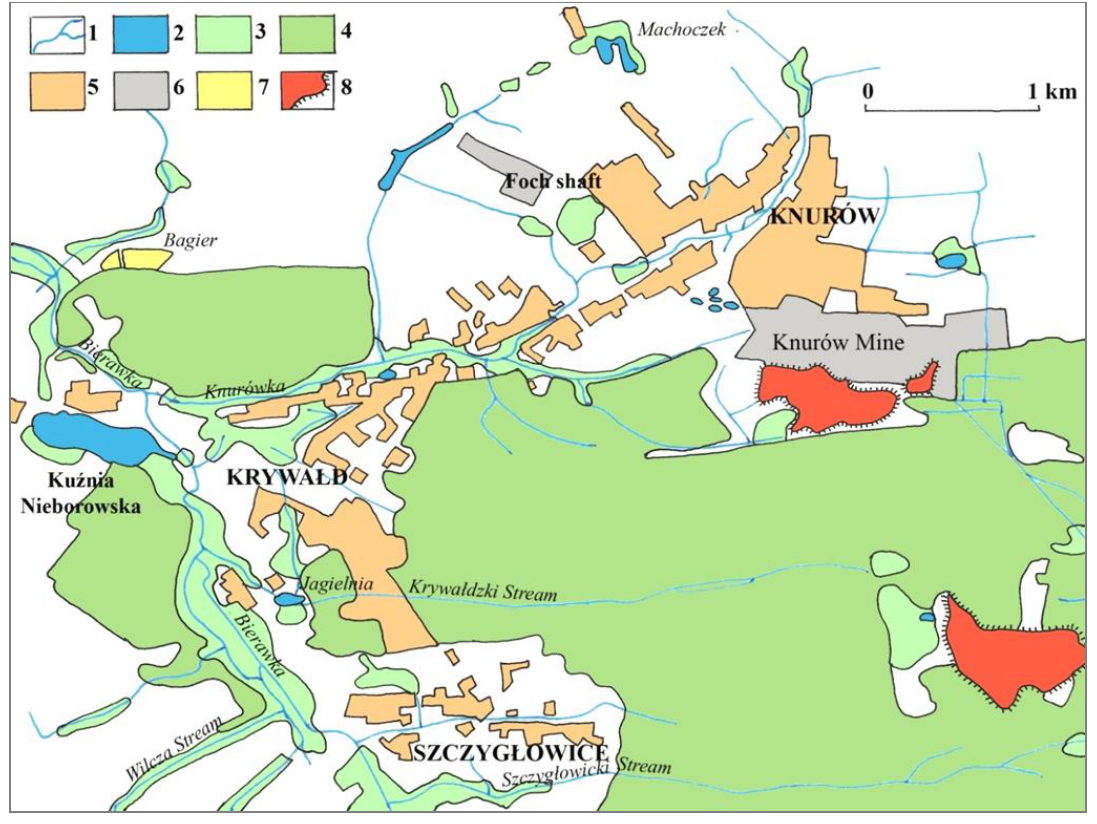
Fig. 2. Water reservoirs in the neighbourhood of Knurów in